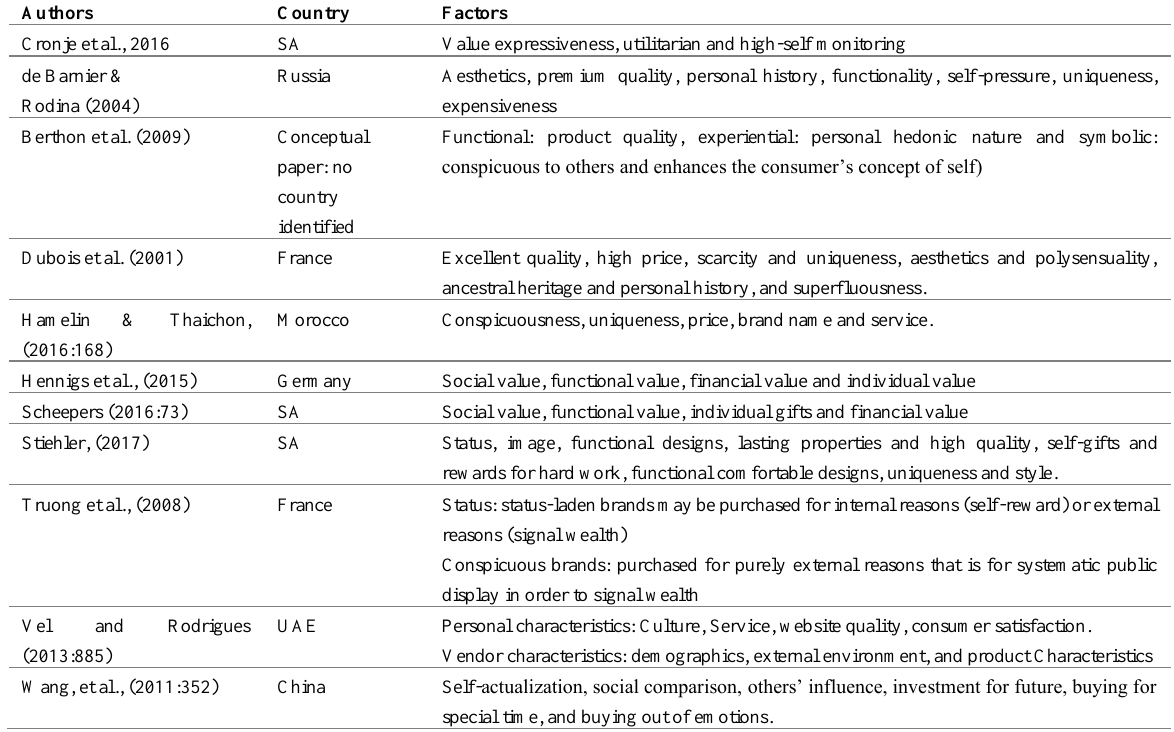
Table 1: Factors influencing luxury product